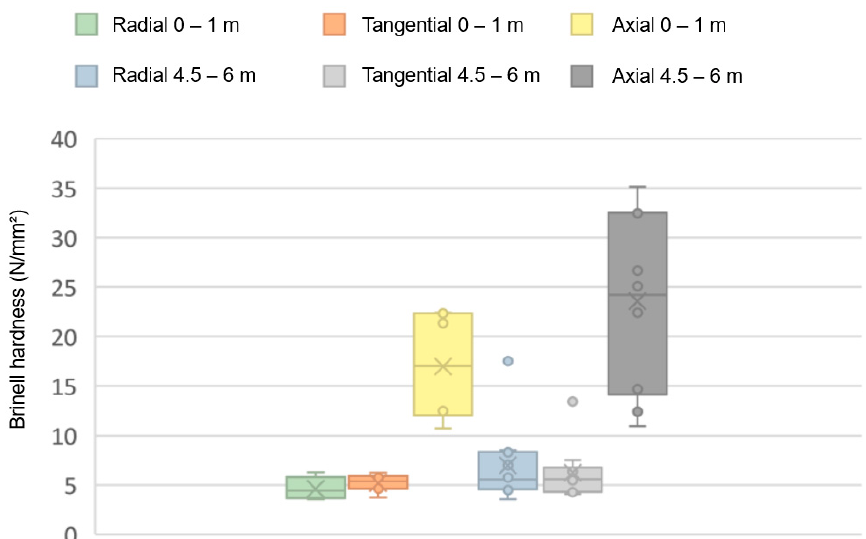
Figure 10. Brinell hardness in the axial, radial, and tangential sections of Paulownia samples extracted at 0–1 m and 4.5–6 m from the tree stem.